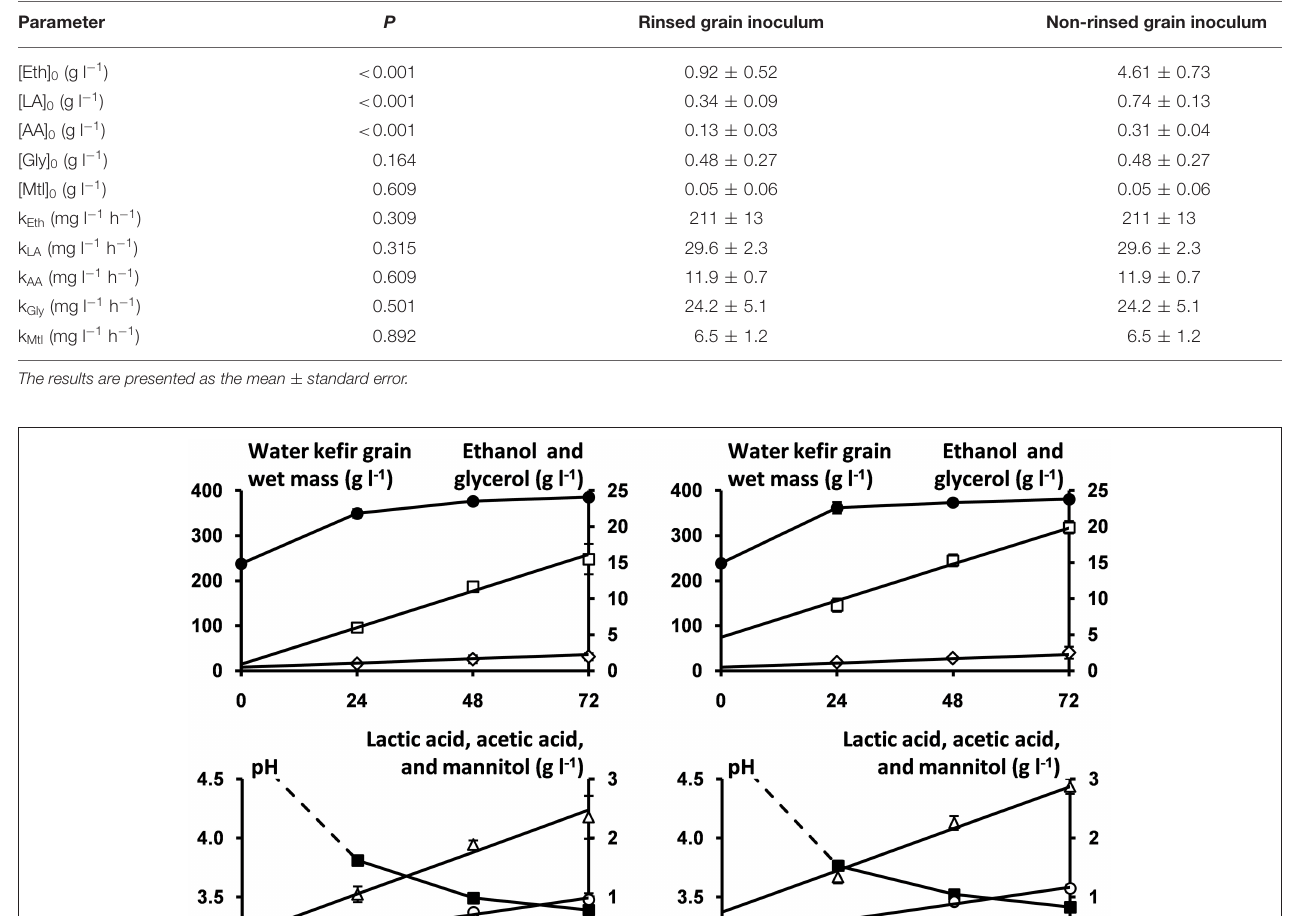
TABLE 1 | Estimated initial concentrations and volumetric production rates for the production kinetics of ethanol ([Eth] 0 and k Eth ), lactic acid ([LA] 0 and k LA ), acetic acid ([AA] 0 and k AA ), glycerol ([Gly] 0 and k Gly ), and mannitol ([Mtl] 0 and k Mtl ) during water kefir fermentation processes started with rinsed or non-rinsed grains; as well as the p -values for the differences between the estimated values for these biokinetic parameters.